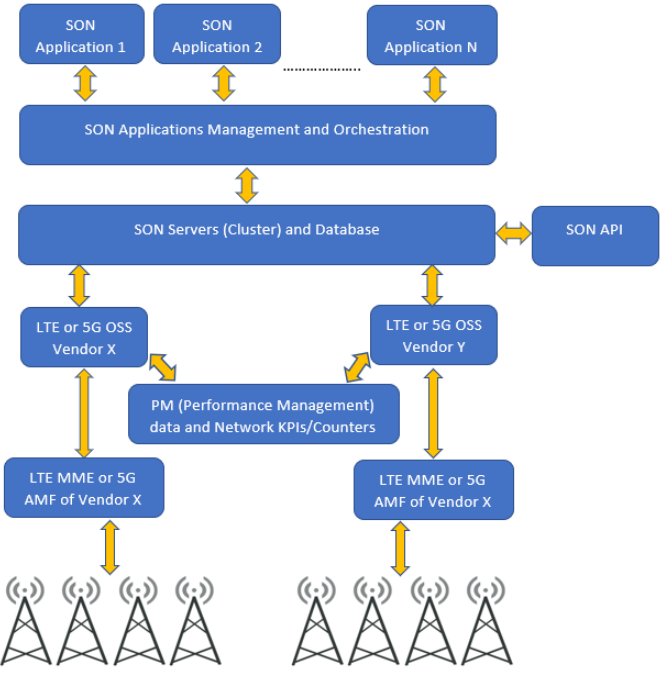
Figure 4. High-level SON system architecture.